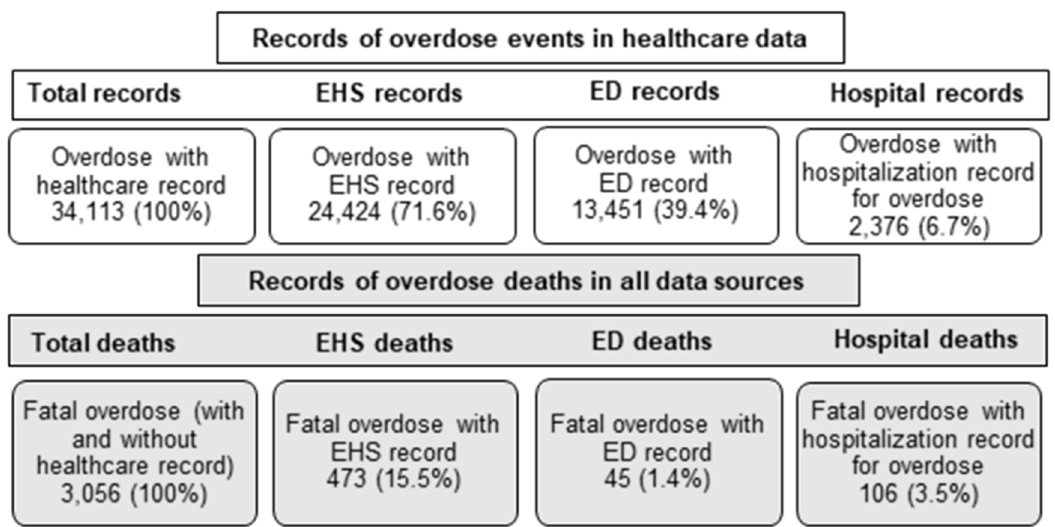
Figure 3: Proportions of overdose events and deaths recorded in healthcare data by source, BC Provincial Overdose